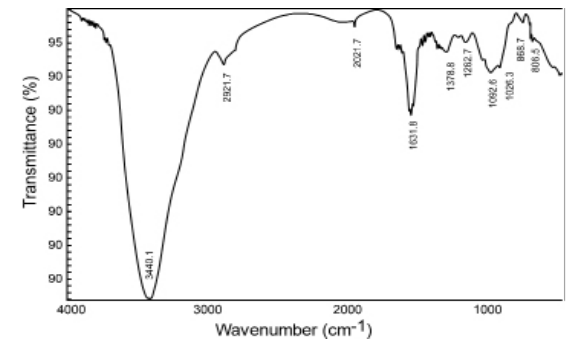
Fig. 3. IR spectrum of the POPs-I.